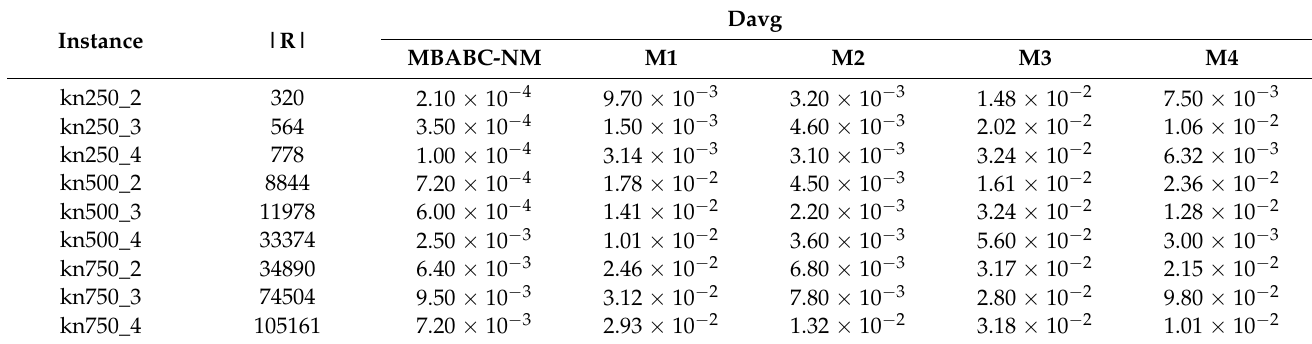
Table 8. Experimental results of MKP dataset in terms of the reference solution and